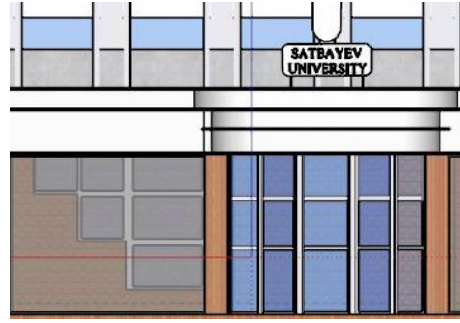
Figure 14. The process of extruding windows.